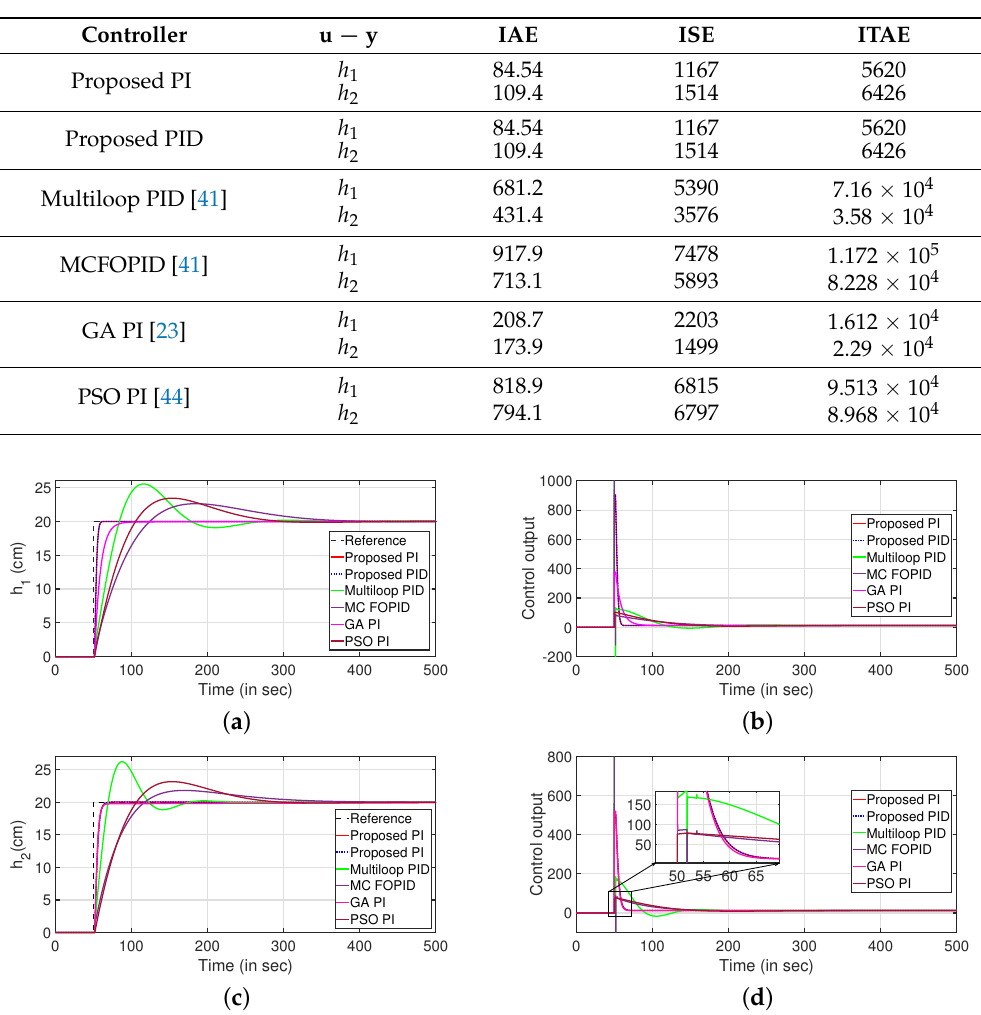
Table 1. Performance indices: coupled conical tank.